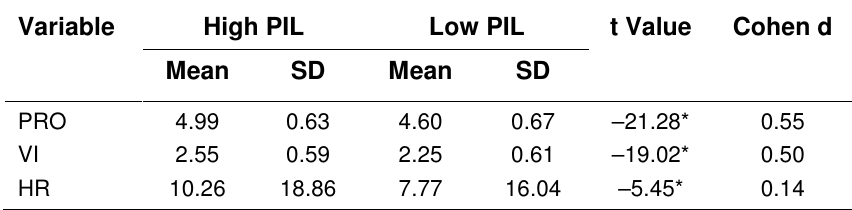
Comparison of Adolescents with High vs. Low Purpose in Life High